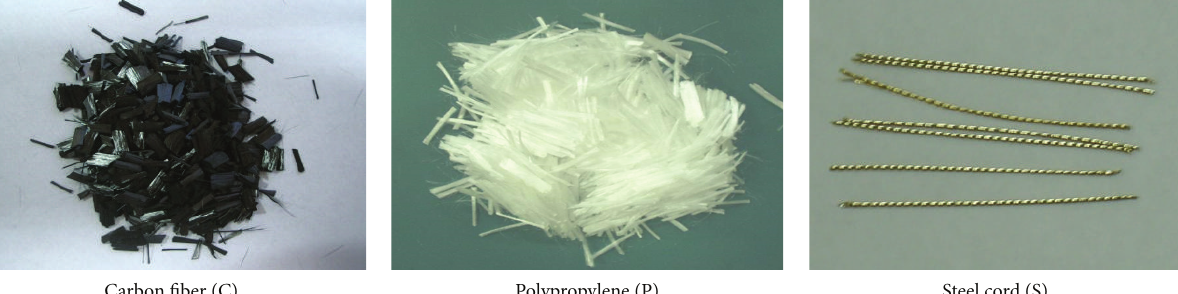
Figure 2: Images of composite